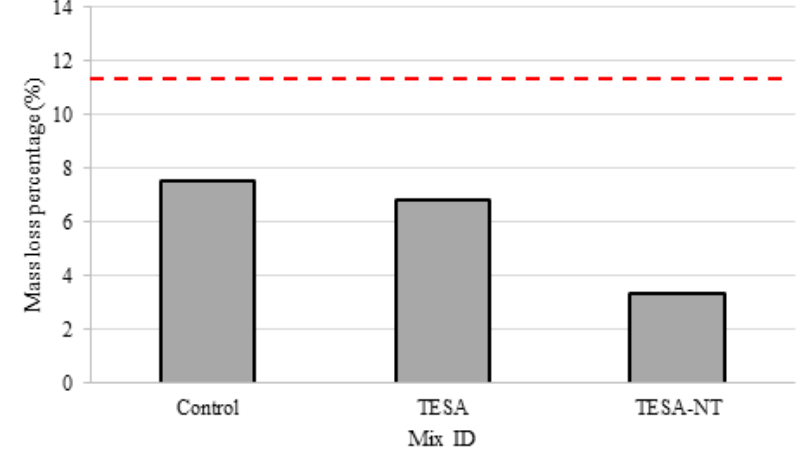
Figure 4. Percentage of rebar mass loss during accelerated corrosion test.